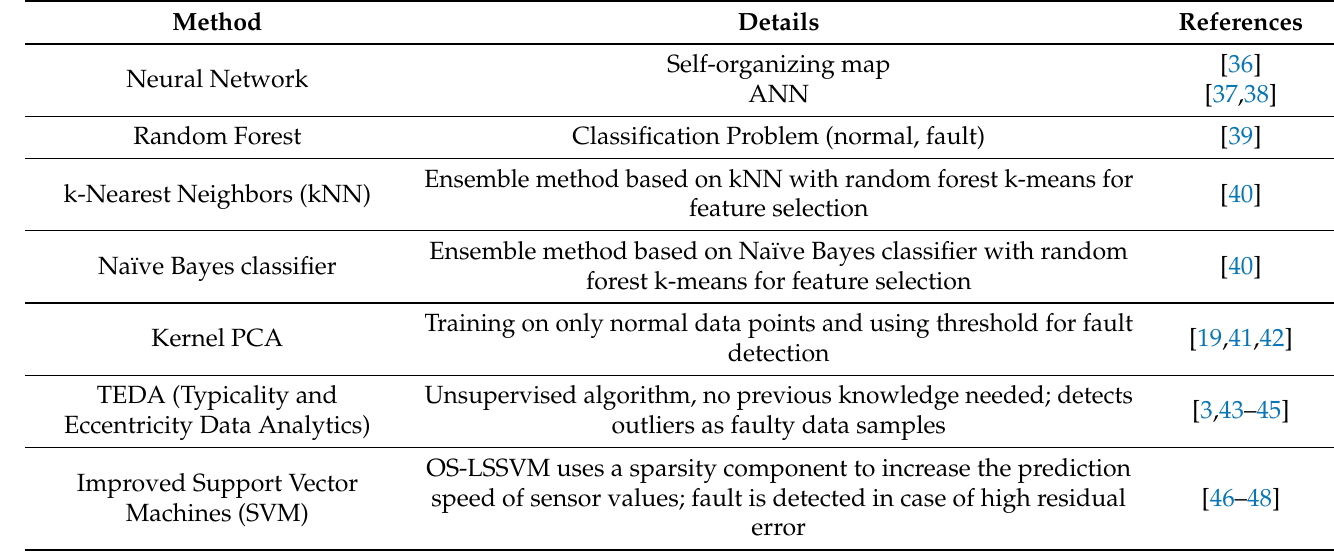
Table 1. Overview of used methods for fault detection with